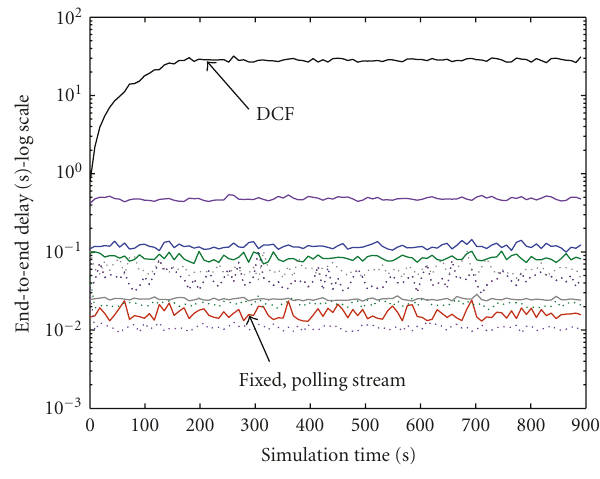
Figure 15: End-to-end delays for scenario